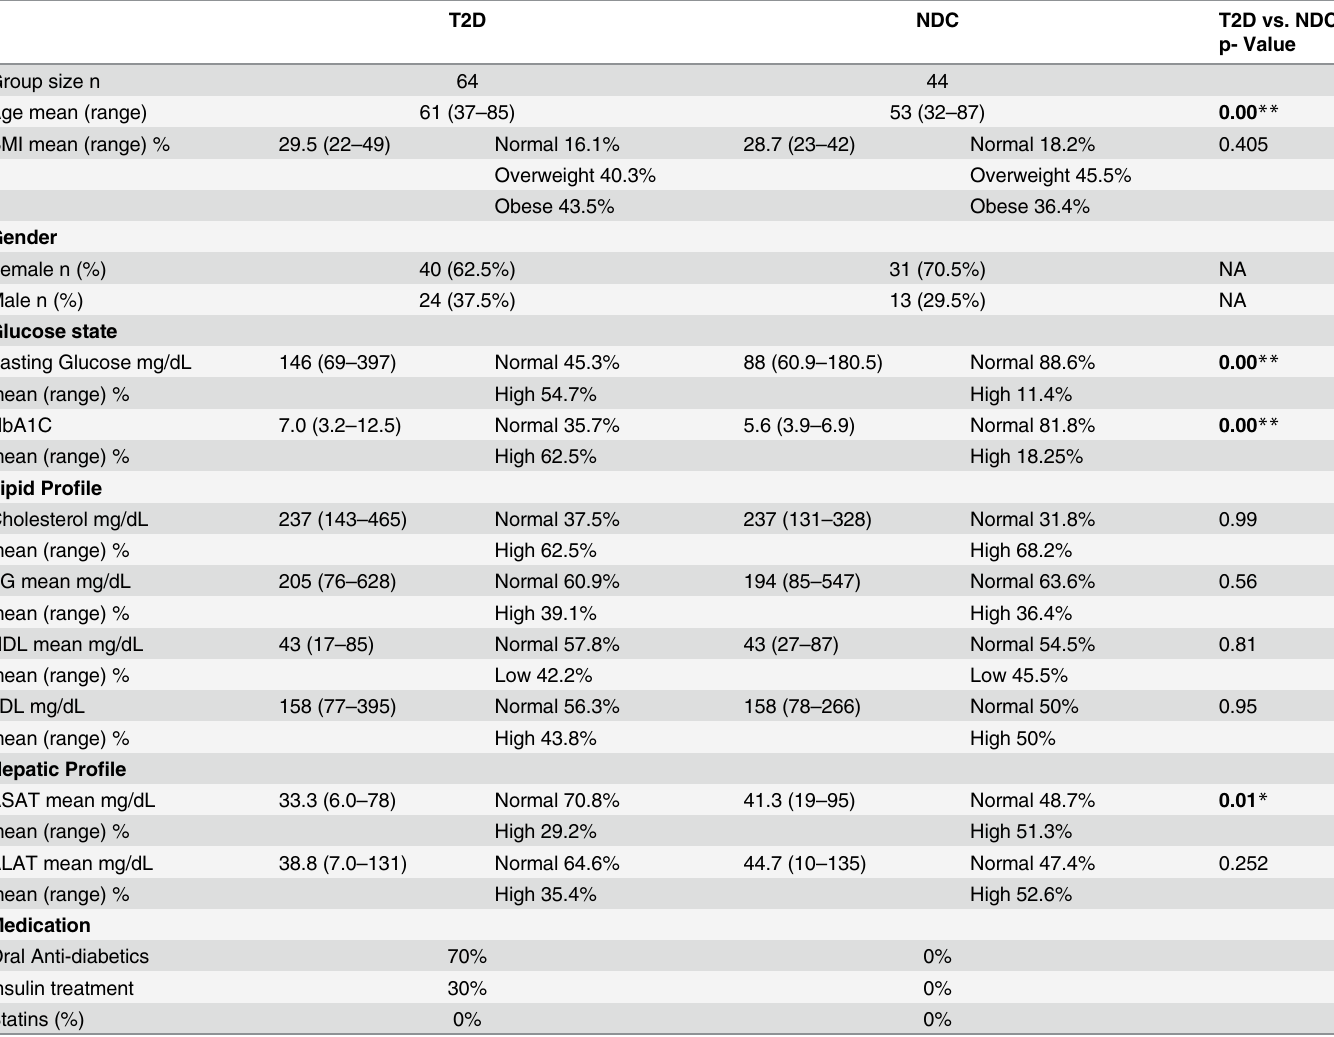
Table 1. Demographic details and clinical characteristics of the validation cohort of Ecuadorian T2D patients and controls. T2D NDC T2D vs. NDC